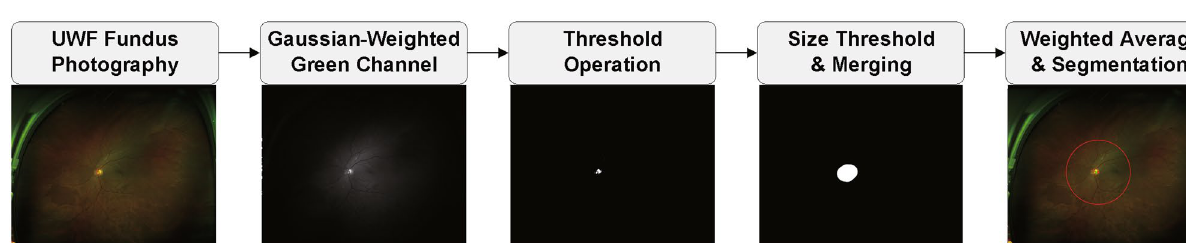
Figure 2. The overall flow of the optic disc and macular detection process.